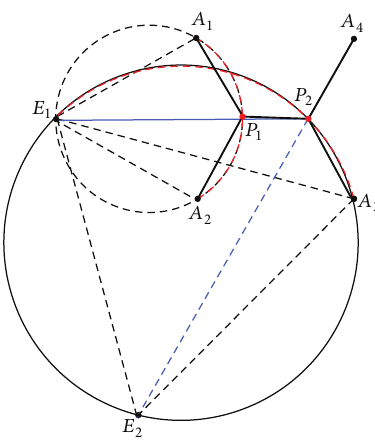
Step 2 (construct FSMT for each subset). We can use VEA to construct FST for subsets containing 𝑛 ( 2 ≤ 𝑛 ≤ 10 )